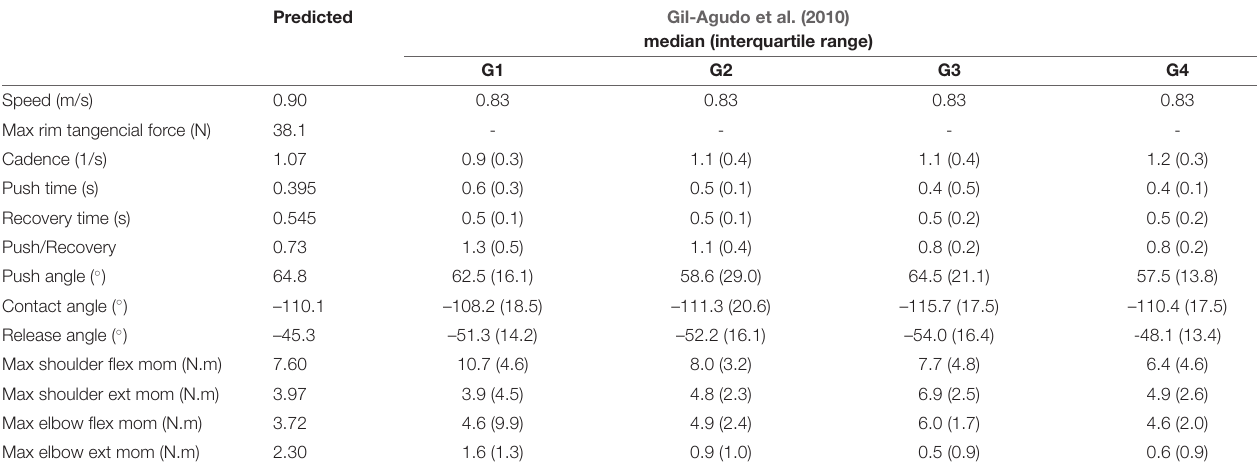
TABLE 2 | Comparison of kinematic, kinetic and spatiotemporal parameters of the steady state simulation at 0.9 m / s to experimental data reported in Gil-Agudo et al. (2010) for locomotion at 3 km / h ≈ 0.83 m / s . Predicted